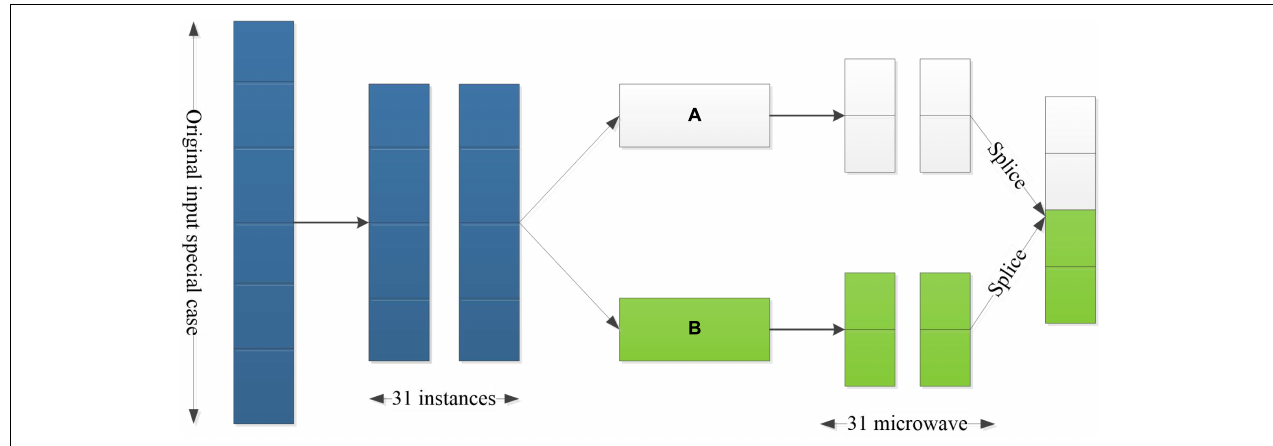
FIGURE 2 | A schematic diagram of multi-scan